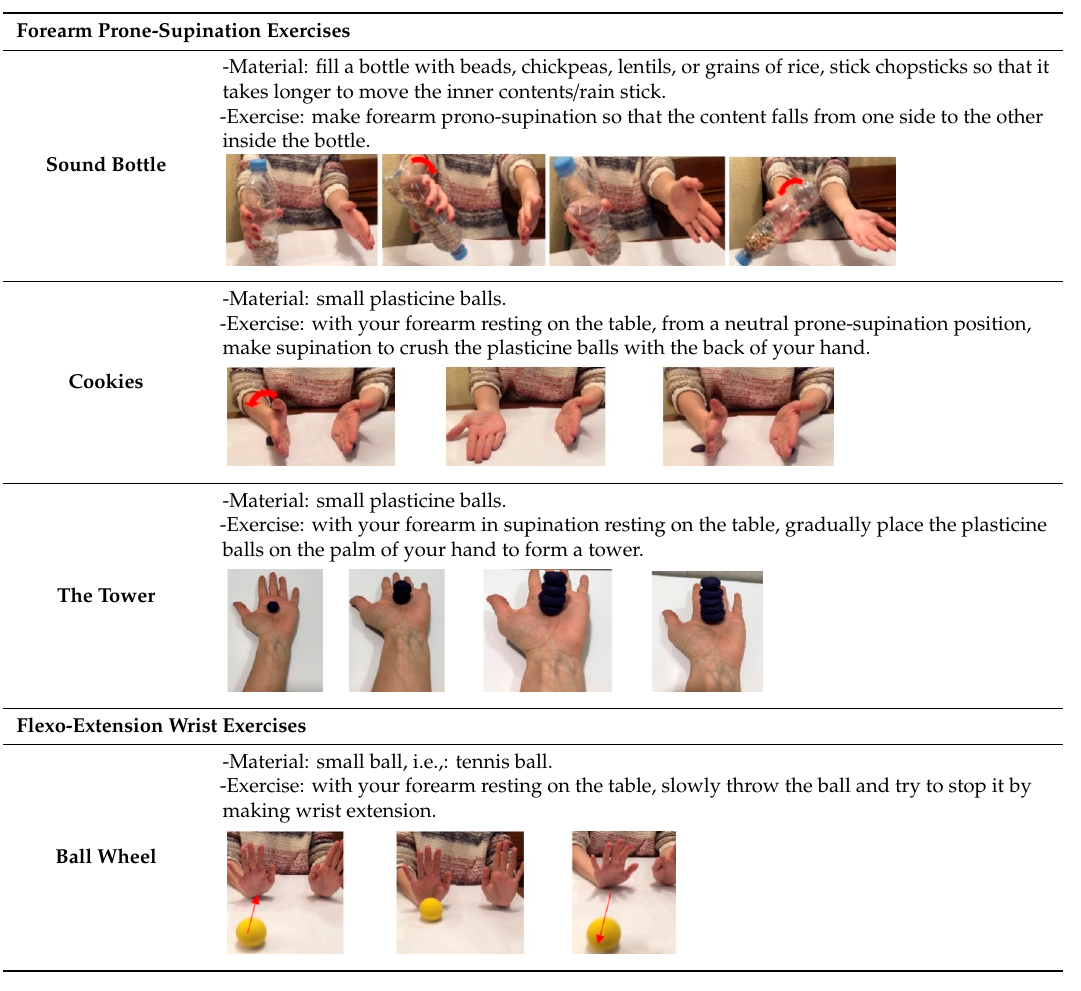
Table 1. Exercises to perform for 4 weeks in both therapies.